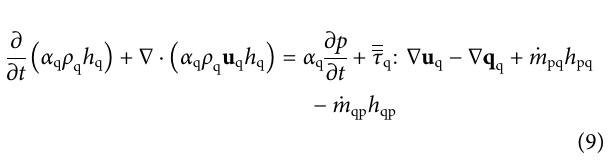
Frontiers in Energy Research |